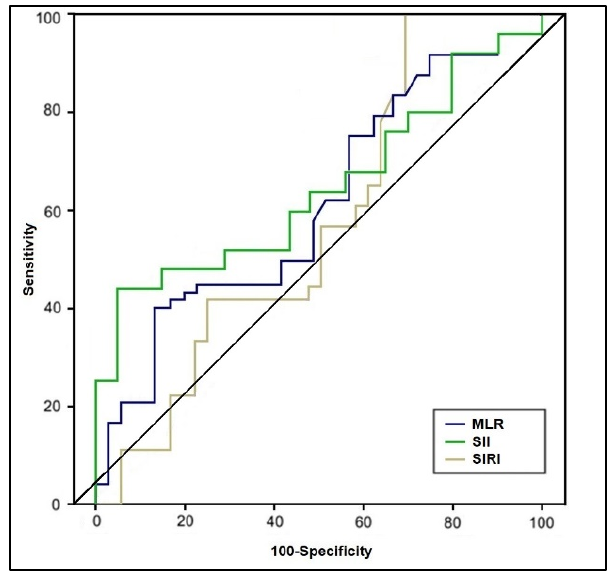
Figure 3. Receiver operating characteristic plots of MLR, SII, and SIRI in predicting premature birth.